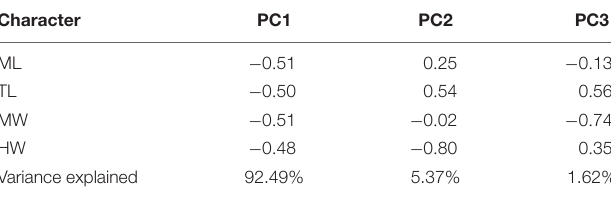
TABLE 5 | Character loadings on the principal components analysis applied for morphological variation of Callistoctopus spp. in Brazil, the Caribbean, Macaronesia and Mediterranean